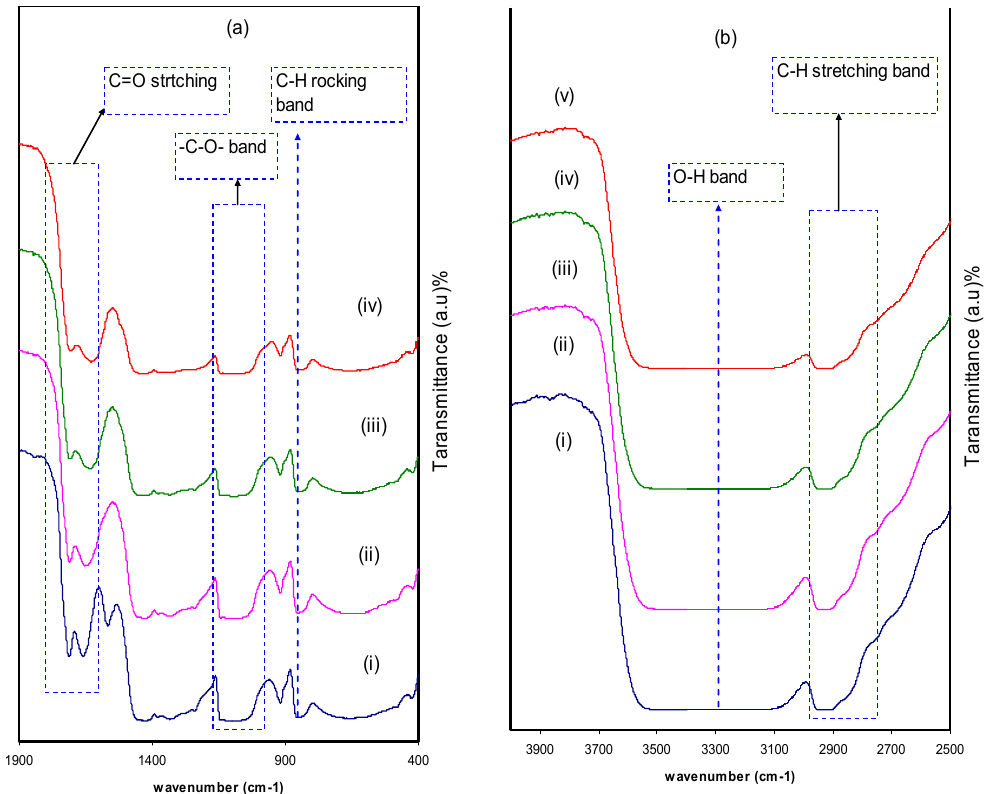
Figure 3. FTIR spectra of (i) PVORG0 (pure Poly (Vinyl Alcohol) (PVA) film), (ii) PVORG1, (iii) PVORG2, and (iv) PVORG3 in the region ( a ) 400 cm − 1 to 1900 cm − 1 , and ( b ) 2500 cm − 1 to 4000 cm − 1 .